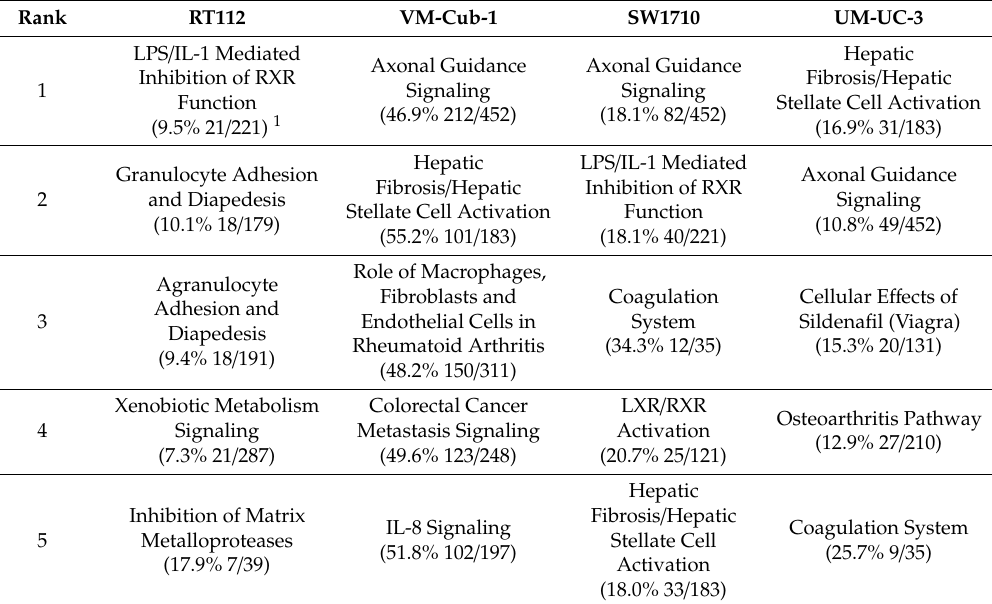
Table 2. Top canonical pathways in HDAC5 versus vector-only transduced UC cell lines.